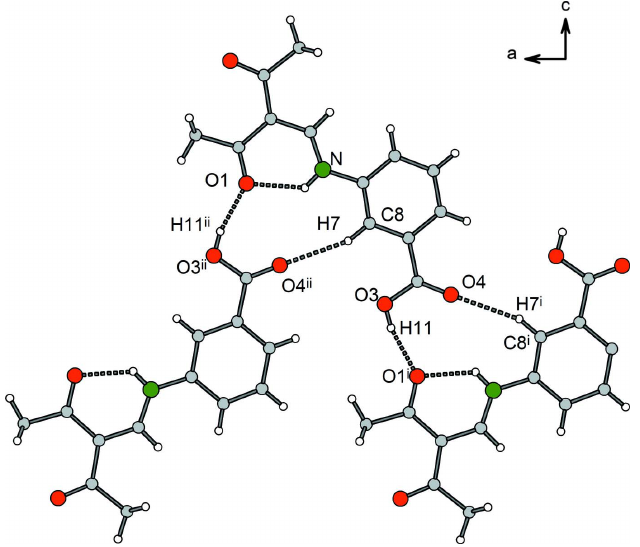
Figure 7 Section of the crystal structure of 2 showing the hydrogen-bonding pattern (dashed lines). Symmetry codes refer to Table 5. Furthermore, the Hirshfeld surface plot hints at a weak C— H (cid:2) (cid:2) (cid:2) O hydrogen bond between the phenylene hydrogen atom H11 and the keto group oxygen atom O1 iii of a neighbouring chain.